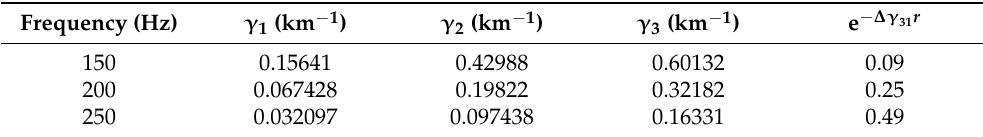
Table 4. Attenuation coefficients of first three normal modes calculated by using inverted geoacoustic parameters and relative amplitude attenuation e − ∆ γ 31 r corresponding to third and first normal modes (source receiver distance r = 5.35